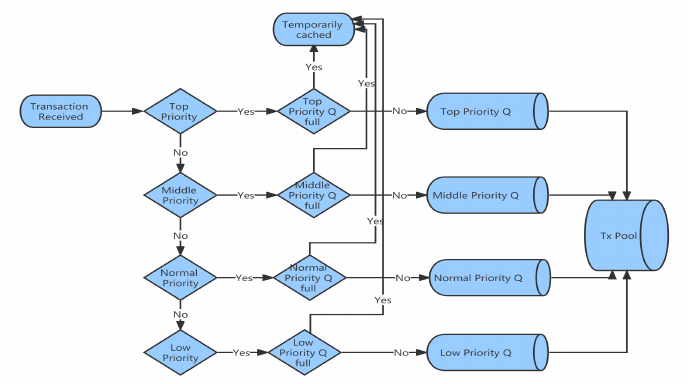
Figure 2. Data flow through which transactions are selected and sent to the transaction pool.